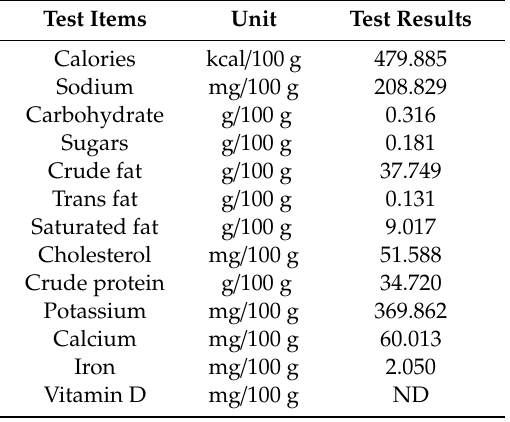
Figure 6. The trimethyl N-oxide (TMAO) was identified and quantified by GC / MS analysis. The representative chromatograms of ( a ) standard TMAO, ( b ) raw HDPS, and ( c ) hot smoked HDPS. The TMAO was identified and quantified by the reference TMAO injecting into the GC / MS. The TMAO spikes in the chromatograms appeared at 1 min 25 s of retention time among di ff erent treatment groups. Table 2. Nutritional composition of hot smoked